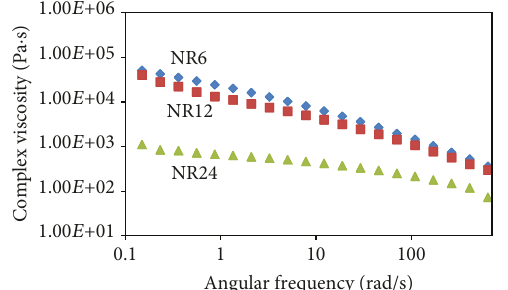
Figure 2: FT-IR spectra of NR and